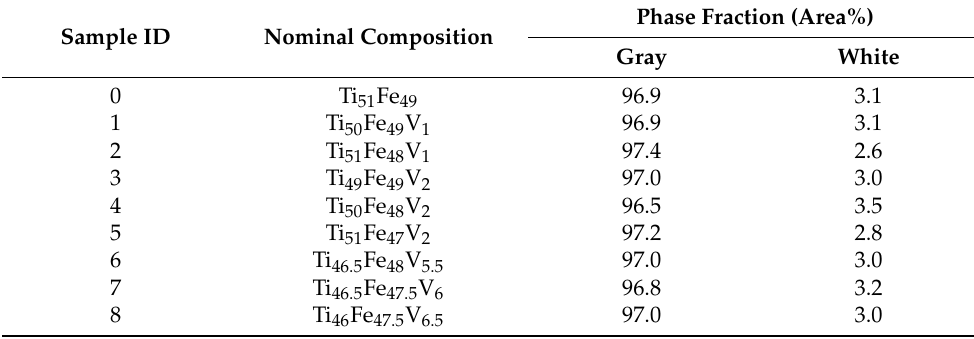
Table 3. Phase analysis of the samples from the SEM micrographs. The phase fractions from the BSE